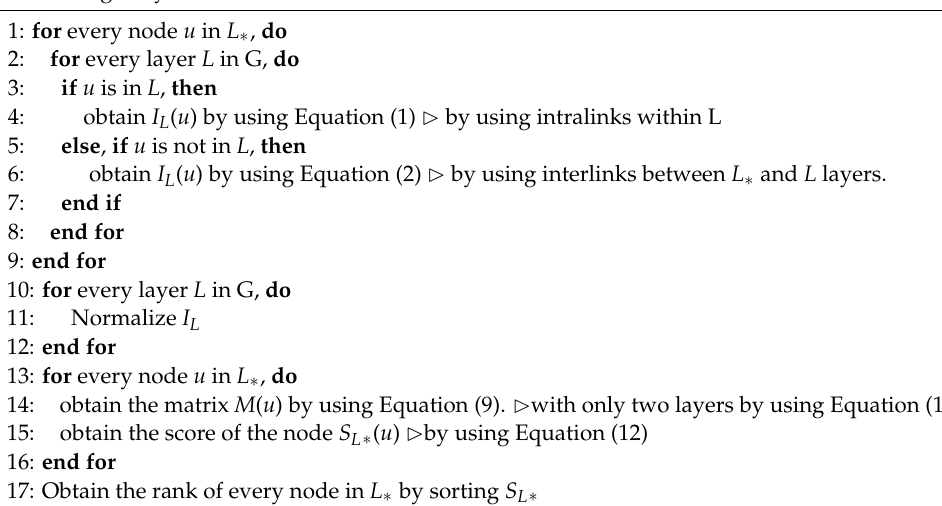
Algorithm 1: corner centrality. Let G = { L 1 , L 2 , ··· , L M }, a multilayer network with M layers. Let L ∗ be the target layer from G